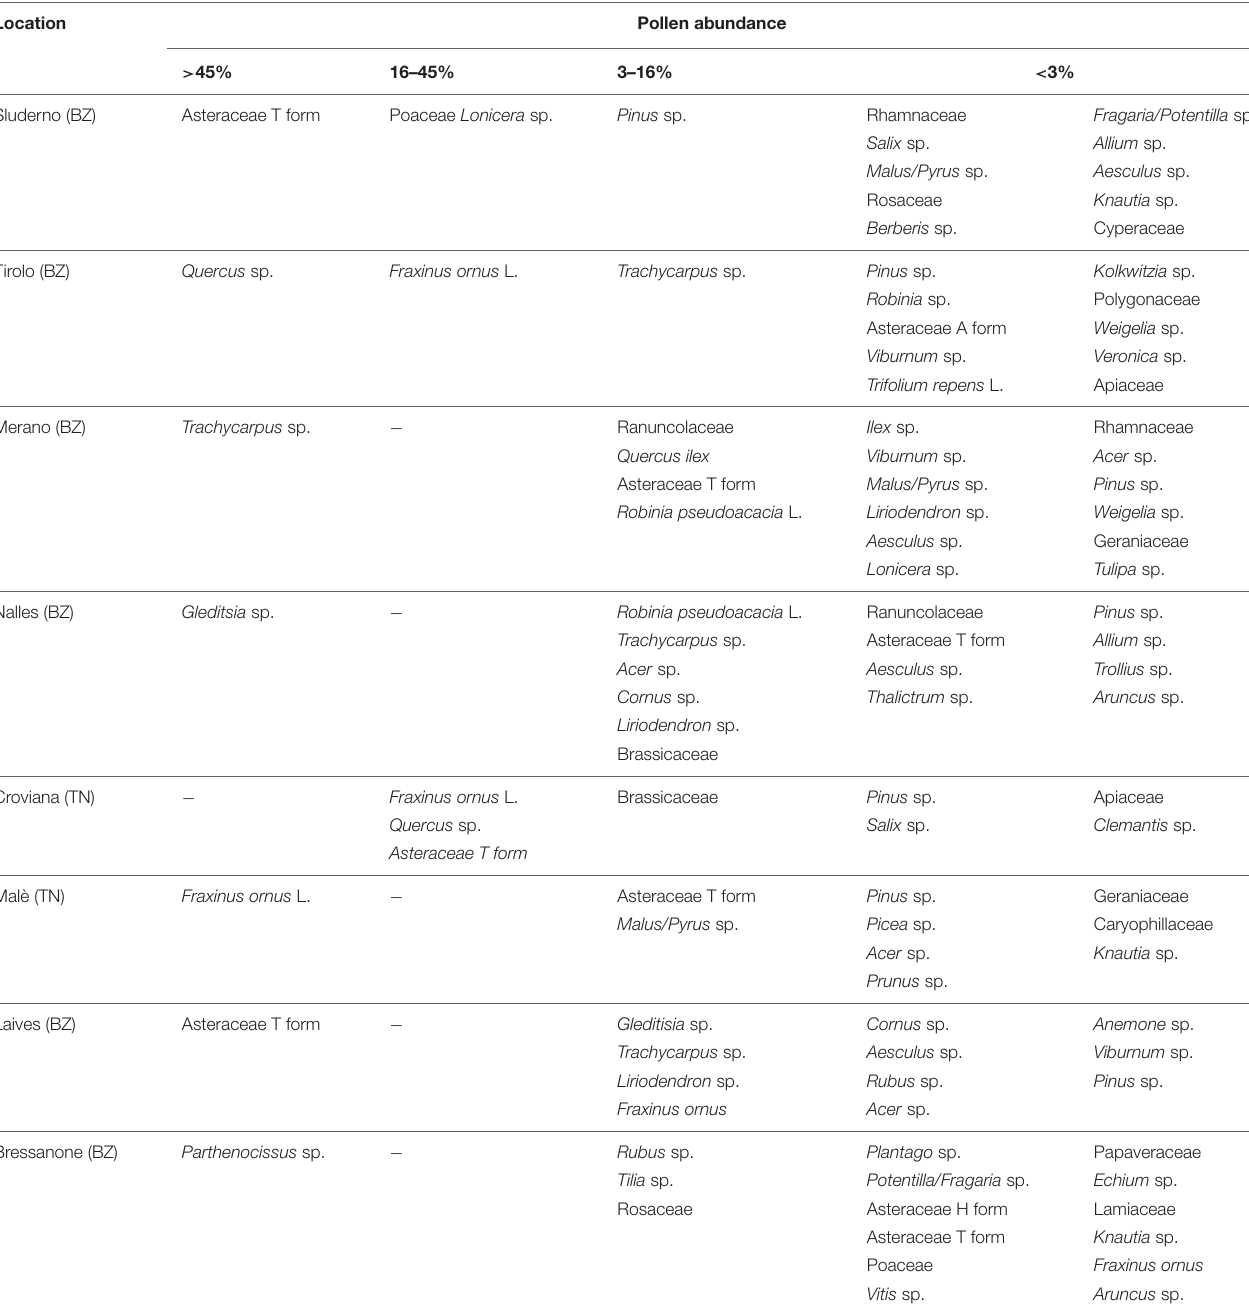
TABLE 3 | Pollen composition of the total samples collected 2 weeks after the end of apple